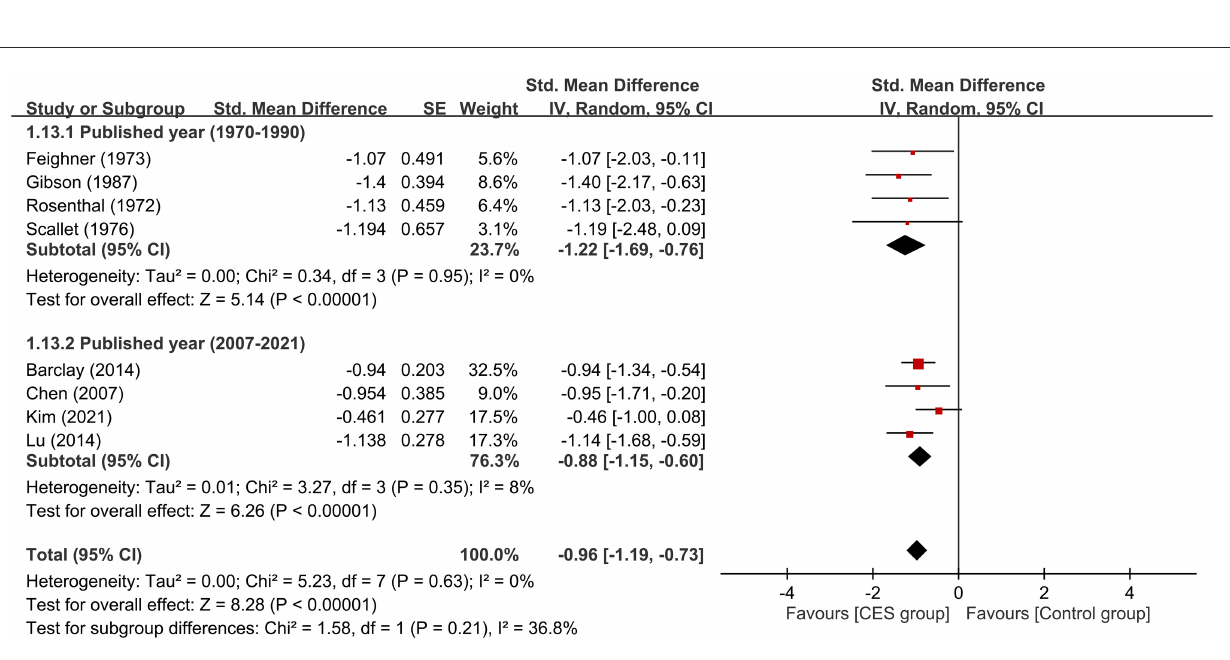
FIGURE5 Subgroup analysis on therapeutic efficacy between studies conducted in 1970–1990 and those published in 2007–2021. CES, cranial electrotherapy stimulation; Std, standardized; CI, confidence interval; SE, standard